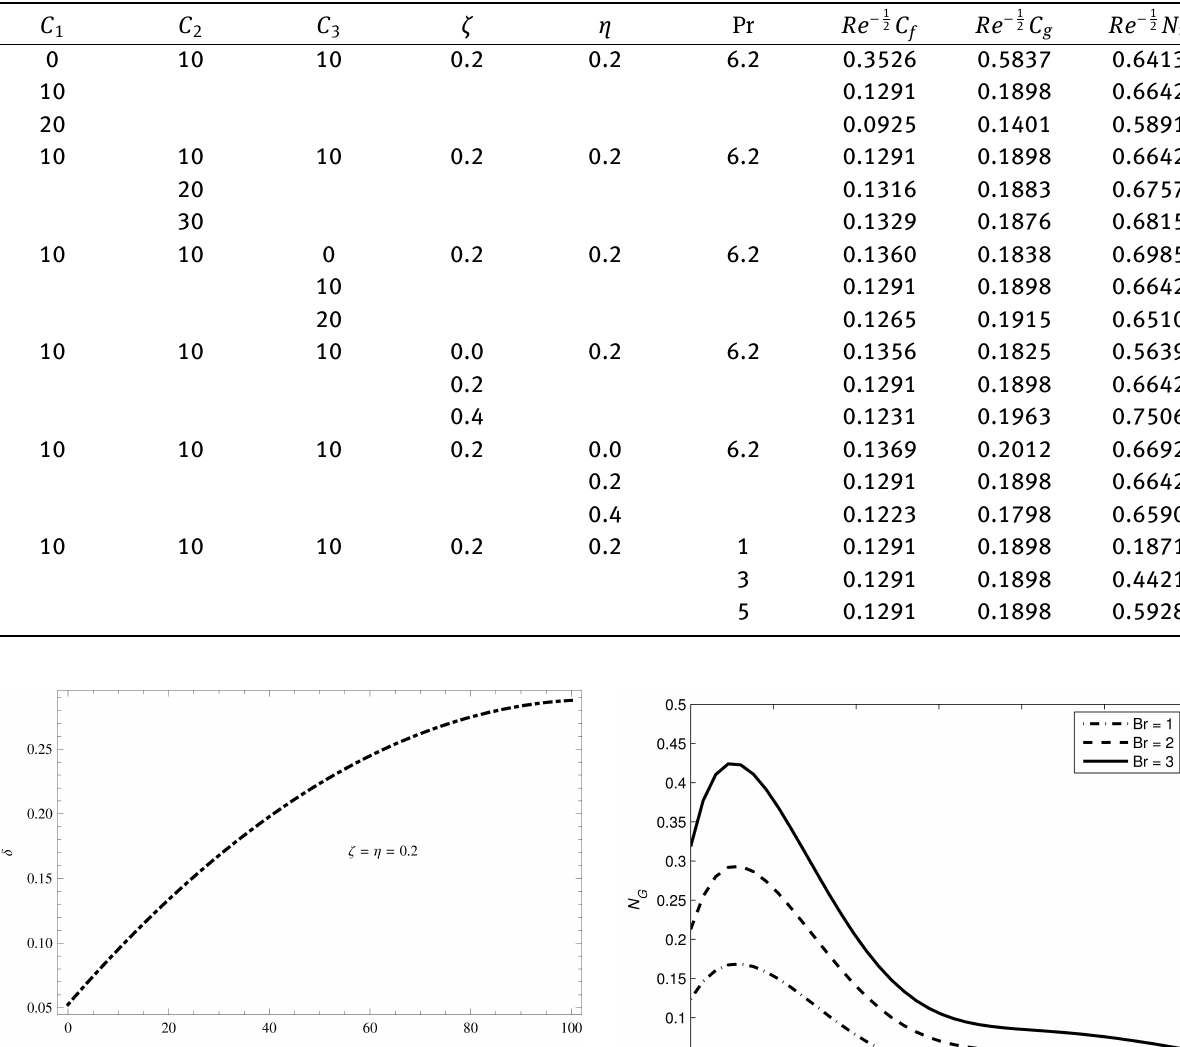
Table 1: Numerical values of local skin friction coeflcients C f and C g , local Nusselt number N u for physical parameters C 1 , C 2 , C 3 , ζ , η and Pr while keeping Re = 2950 and Br = 1